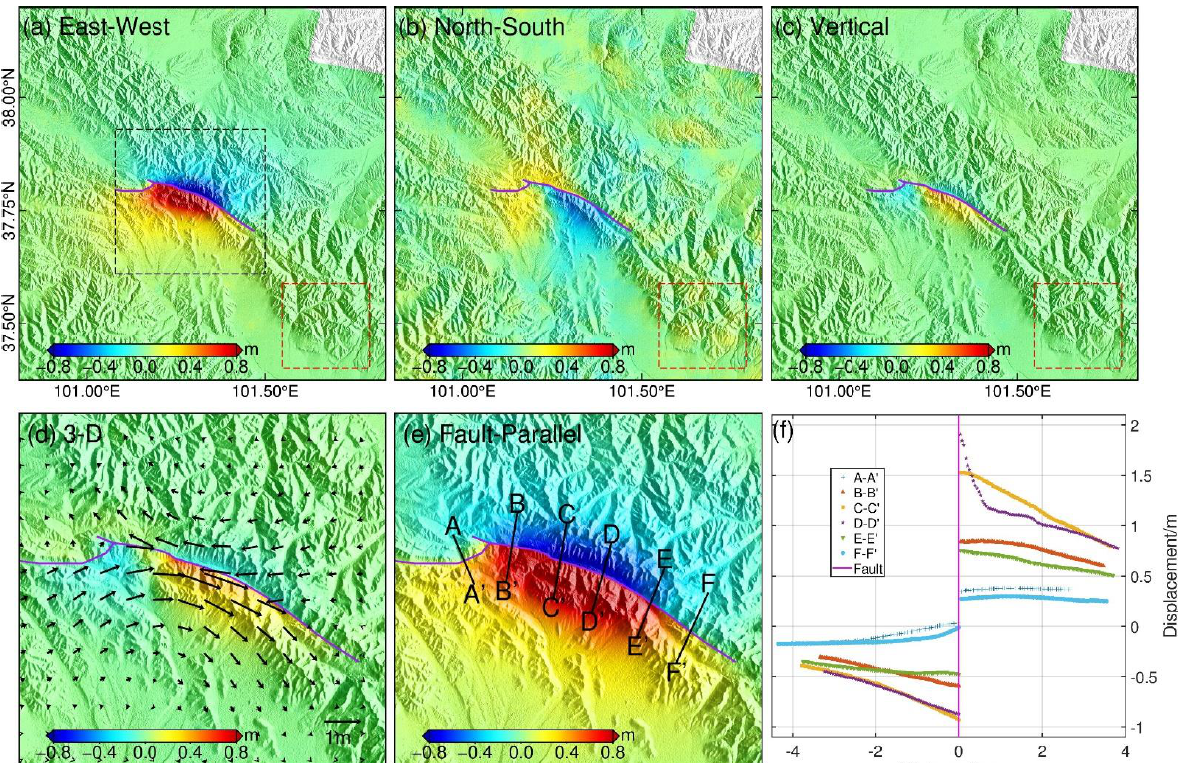
Figure 3. Three-dimensional co-seismic displacements of the 2022 Menyuan earthquake derived using the SM-VCE method. The black dashed rectangle in ( a ) is the range of ( d , e ). The red dashed rectangles in ( a – c ) are the areas for estimating the variance of the corresponding displacement component. The base map in ( d ) is the vertical displacement, and the arrows are the down-sampled horizontal displacements. ( e ) Fault-parallel horizontal displacements, where the negative and positive values represent northwestward and southeastward horizontal displacements, respectively, and the black lines are the selected profiles across the fault, i.e., profiles A-A’, B-B’, C-C’, D-D’, E-E’, and F-F’. ( f ) The absolute fault-parallel horizontal displacements across the fault.